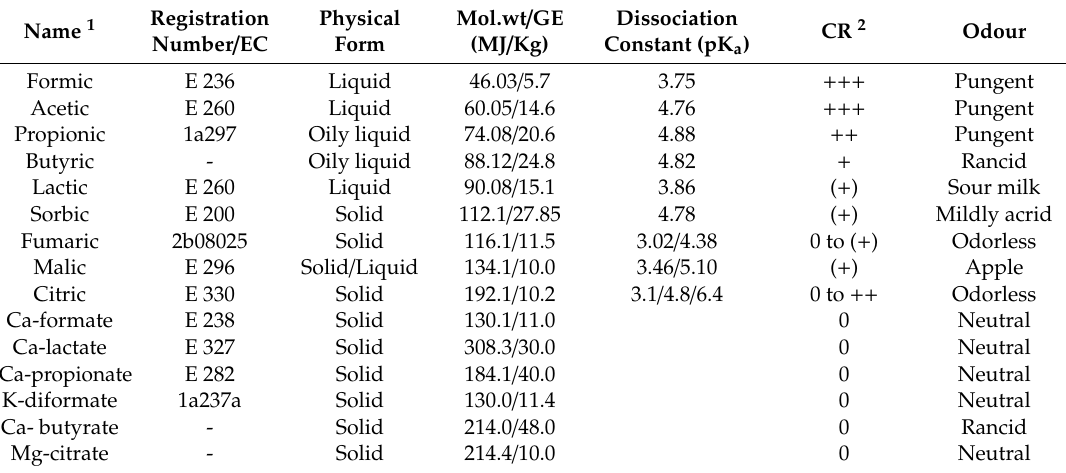
Table 1. Physicochemical properties of most common SCFAs and their